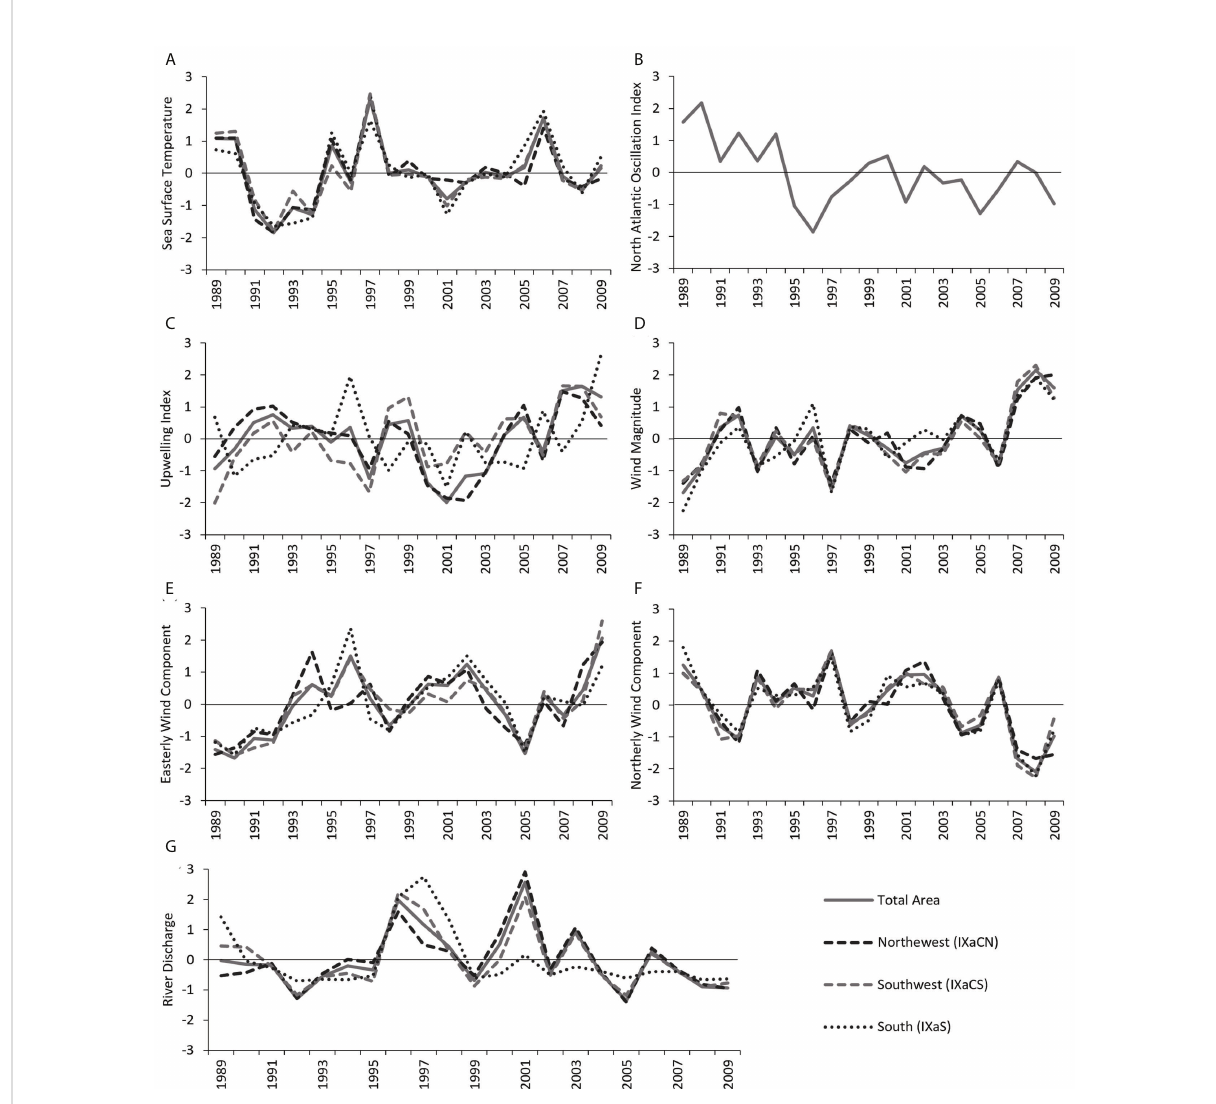
FIGURE 2 Standardized time series of the yearly oceanographic, hydrological and climatic variables for the period from 1989 to 2009 along the Portuguese coast: Northwest (IXaCN), Southwest (IXaCS) and South (IXaS). (A) Sea surface temperature (°C), (B) North Atlantic Oscillation Index, (C) Upwelling Index, (D) Wind magnitude (m.s-1), (E) Easterly wind component (m.s-1), (F) Northerly wind component (m.s-1), and (G) RD – River discharges